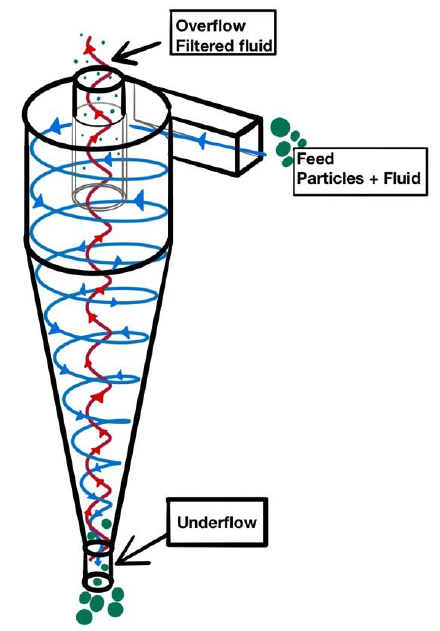
Figure 1. Hydrocyclone schematic representation.